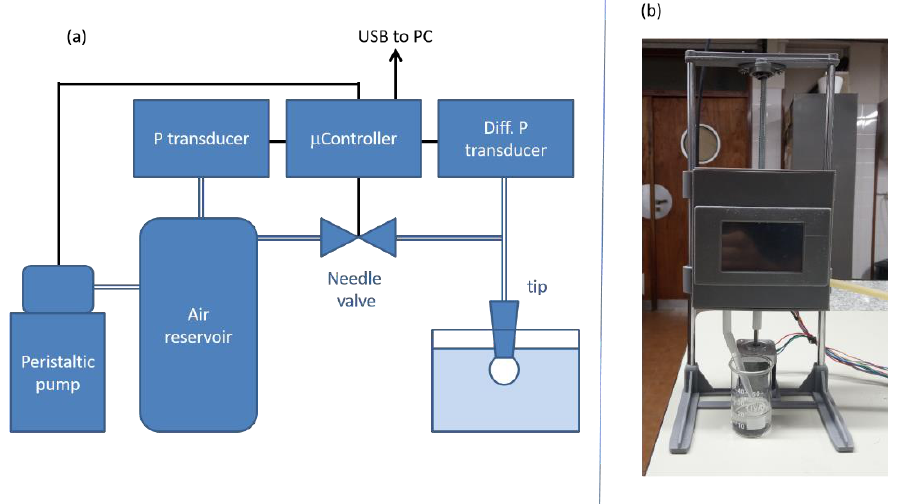
Figure 1. ( a ) Scheme of the Maximum Pressure Apparatus. ( b ) Picture of the device showing the